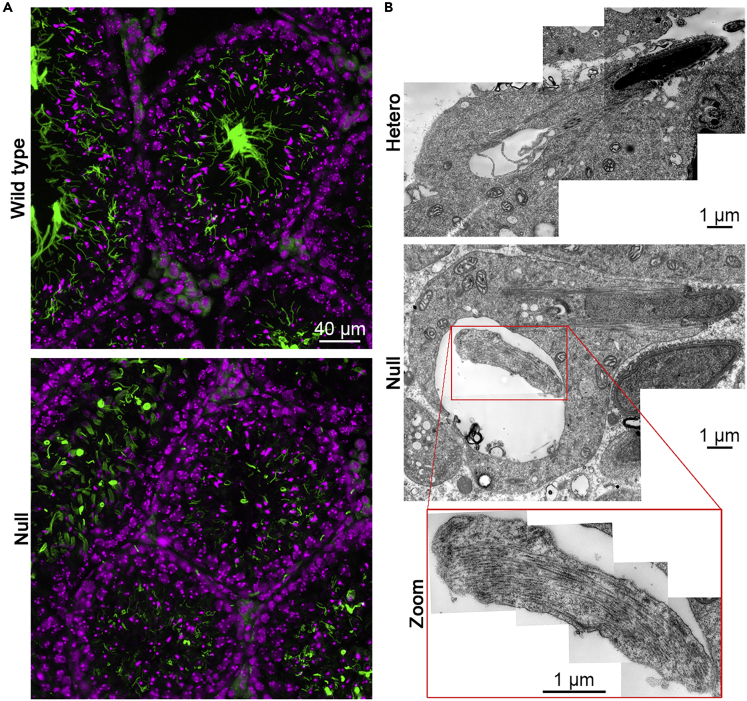
Hoatz−/− Seminiferous Tubules Exhibit Structural Defects(A) Representative fluorescence microscopy images of the testes from wild-type and Hoatz−/− mice. The sections were subjected to immunohistochemistry to detect acetylated α-tubulin (green). Nuclei were detected using DAPI (pseudocolored magenta). Scale bar, 40 μm.(B) Representative transmission electron microscopy (TEM) image tiling of spermatids undergoing cytodifferentiation in the asymptomatic heterozygous and Hoatz−/− mutants. In the Hoatz−/− mutant, a deformed flagellum contained an abnormal bundle of filaments (magnified).See also Figures S4 and S5.